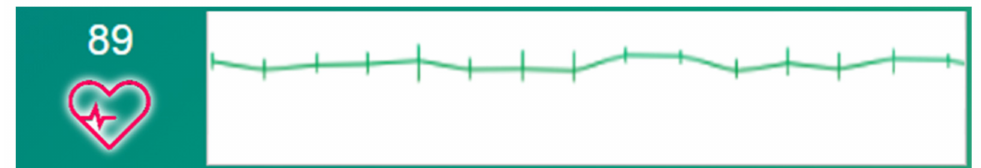
Figure 5. Plotting the mean pulse of the driver, while the vertical segments represent the